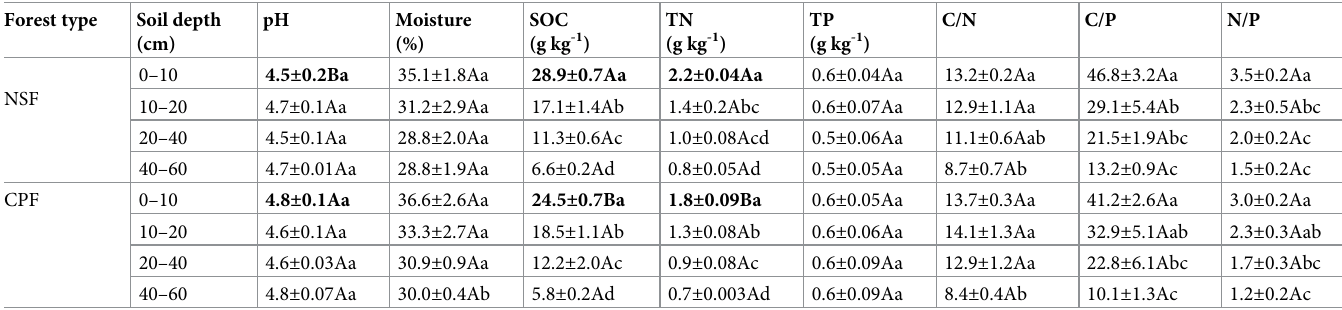
Values are means ± stand error (n = 3). Moisture: soil moisture content; SOC: soil organic carbon; TN: soil nitrogen; TP: soil total phosphorus. Capital letters show the significant difference between the two forests at the same soil depth, and the different lower cases reflect the significant difference among soil depths within one forest ( p <